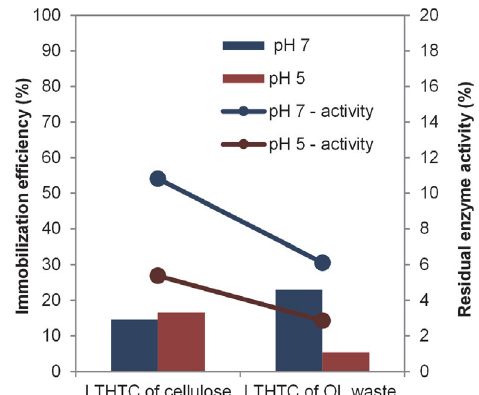
Figure 2. Influence of crosslinker on immobilization efficiency and residual enzyme activity. Reaction conditions: 5 mg of chosen bio- char, enzyme concentration of 2.3 mg/mL, PBS with pH 7, 7-h im- mobilization of enzyme with continuous stirring at 300 rpm, at am- bient temperature and at atm. pressure. Standard deviation for all measurements was less than ± 3%.